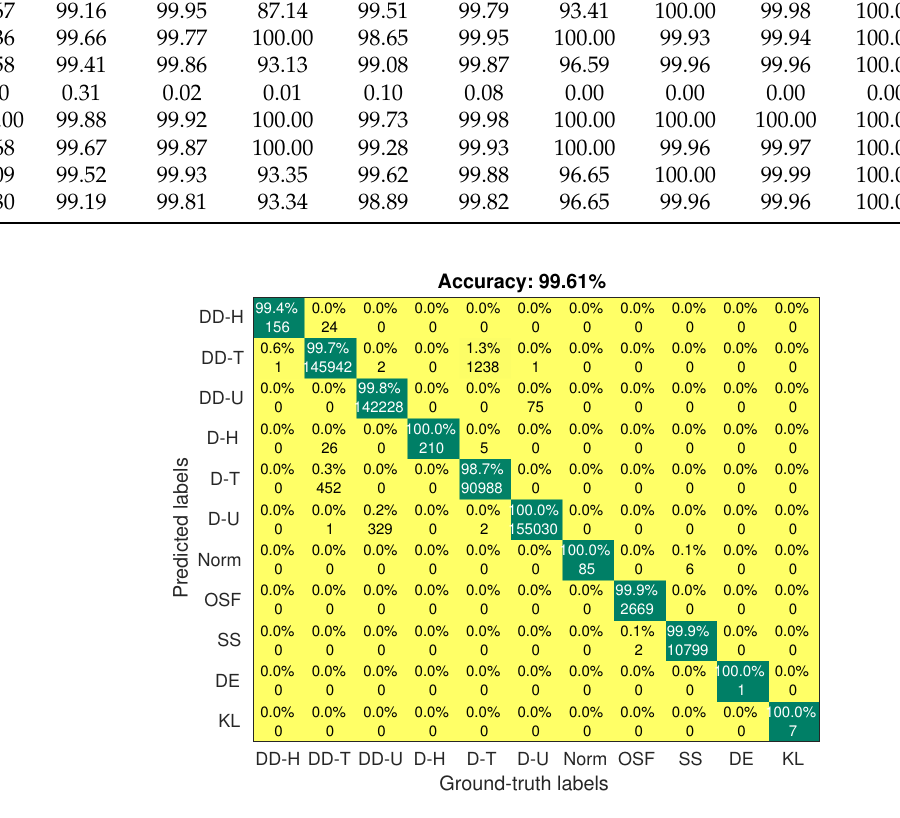
Figure 8. Confusion matrix of LS-DRNN